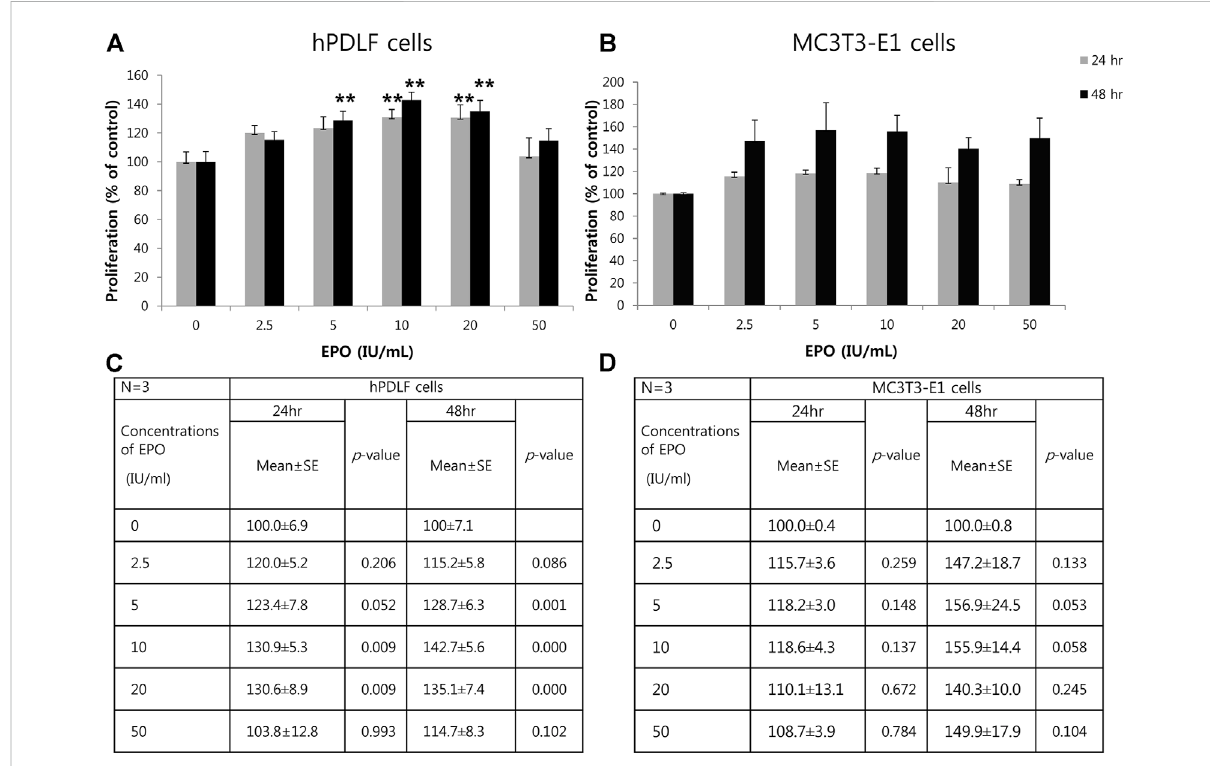
FIGURE 1 EffectofEPOonproliferationofhPDLFcells (A,C) andMC3T3-E1cells (B,D) .After24and48 hincubation,acellproliferationassayisconducted using a Cell Counting Kit-8 (CCK-8). The experiments are conducted three times independently. Treatment groups with 5, 10, and 20 IU/ml EPO show signi fi cantly higher values than the control group ( p < 0.01) at 24 and 48 h in hPDLF cells (A,C) . In MC3T3-E1 cells (B,D) , higher proliferation rates are reported for EPO-treated groups, which show the highest values at 5 and 10 IU/ml EPO at both 24 and 48 h, than the control group.Dataareshownasmean±standarderror(SE).*Statisticallysigni fi cantdifferencescomparedtotheuntreatedcontrol( p < 0.05).**Statistically signi fi cant differences compared to the untreated control ( p <